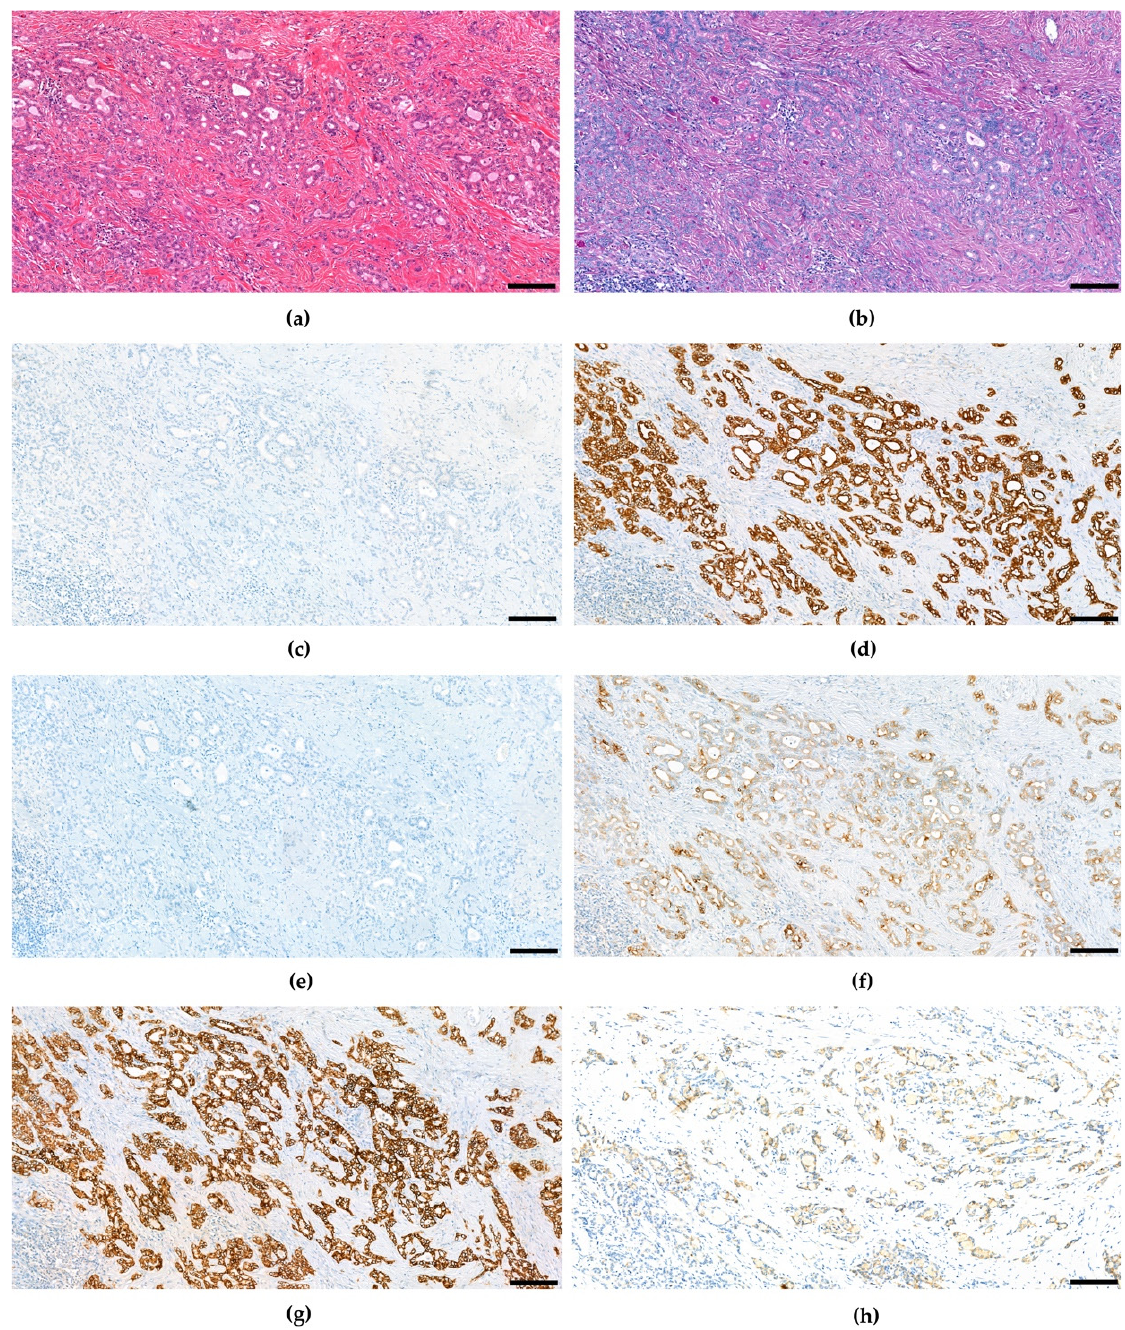
Figure 5. Combined hepatocellular and cholangiocellular carcinoma, cholangiocellular component ( a ) H&E. ( b ) PAS. ( c ) HepPar1. ( d ) CK7. ( e ) Arginase-1. ( f ) CK19. ( g ) EpCAM. ( h ) CD56. Scale bar: 100 µm.